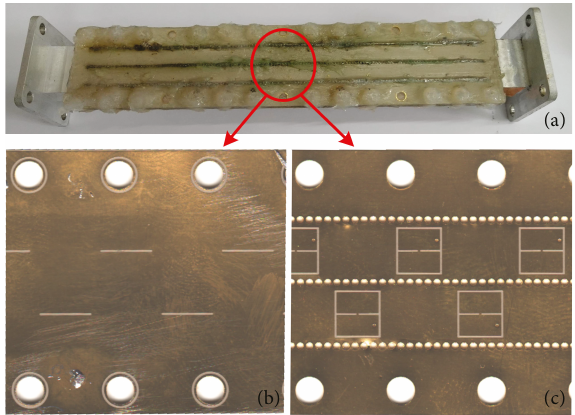
Figure 12: Photos of the fabricated sample. (a) waveguide slots array antenna, (b) slot layer, (c) metasurface